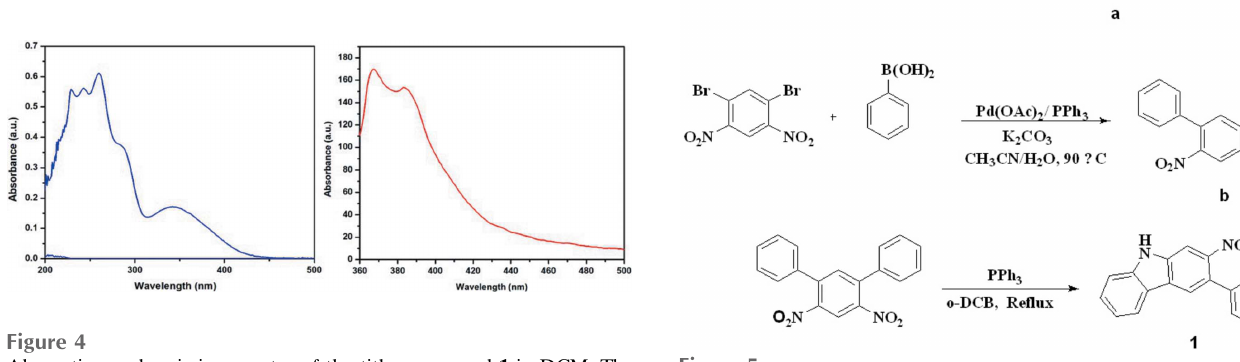
Figure 5 Reaction